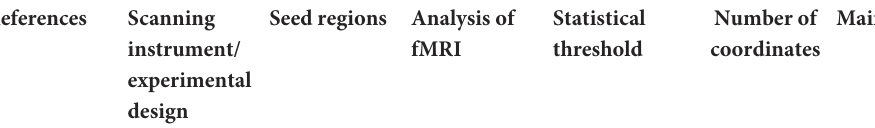
TABLE 2 Scanning methods and major brain region alterations in the included